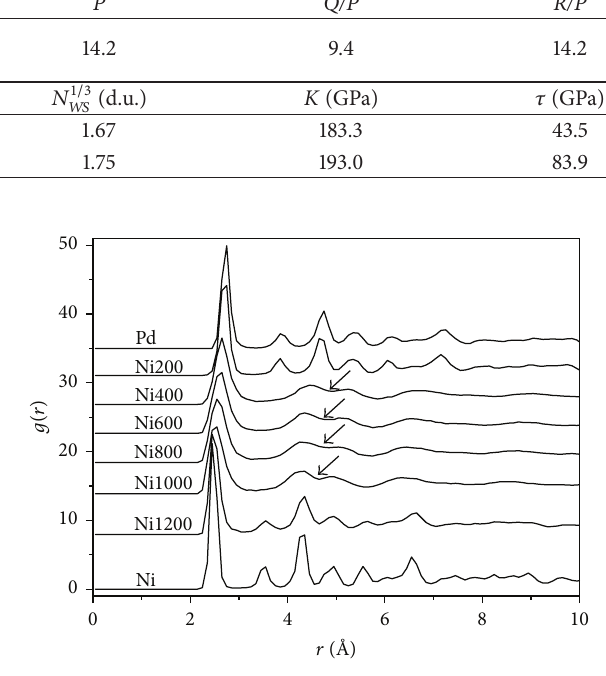
Figure 2: Radial distribution function (RDF) of Pd-Ni clusters at 300 K with the cooling rate of 4